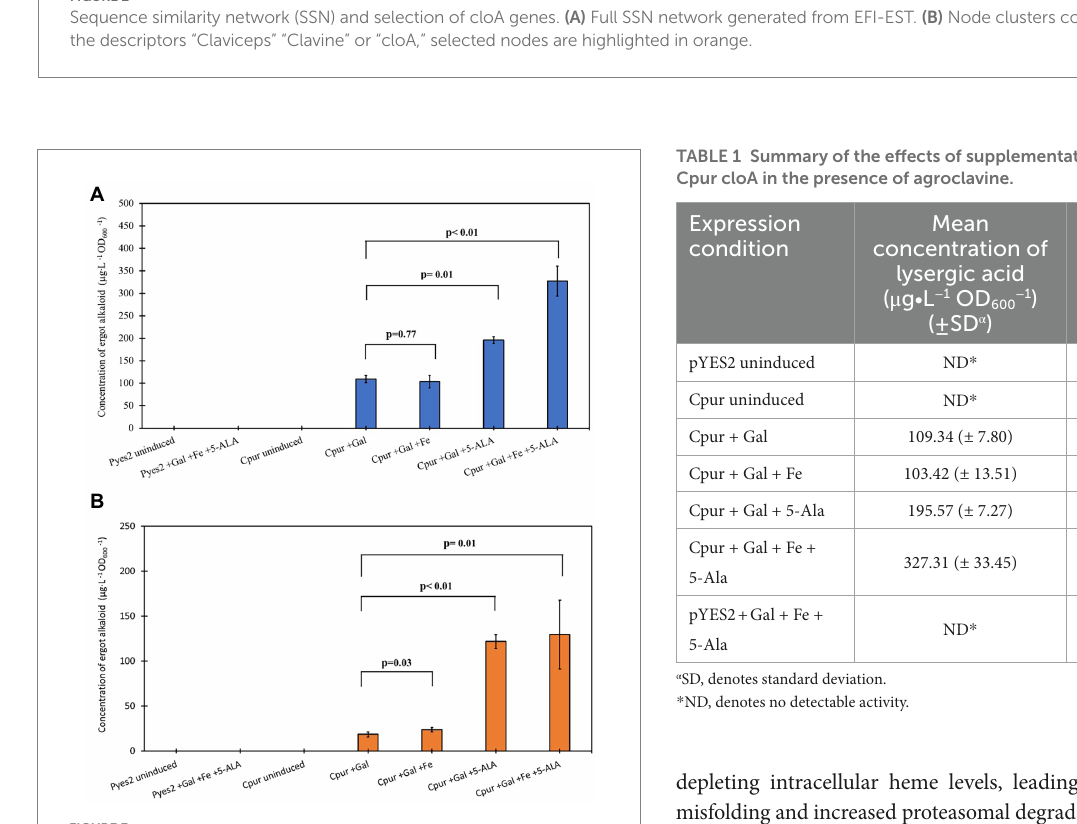
FIGURE 3 Screening the effects of supplement addition on CloA activity. Blue bars represent the mean concentration of lysergic acid while orange bars represent the mean concentration of elymoclavine produced by CloA orthologs. Error bars are representative of three biological replicates.